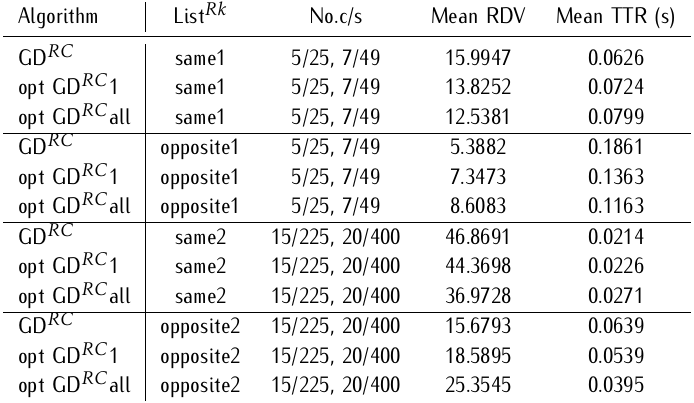
Table 9. Asynchronous CRs with asymmetric channel views: Average (Mean) number of potential RDVs per cycle and average TTR (seconds) for optimized RAC 2 E with UP slot allocation optimized (a) for the best channel only (opt UP1) (b) for all channels (opt UPall) in comparison with UP from Section 4; No.c/s stands for Number of channels / slots; List Rk is the channel ranking